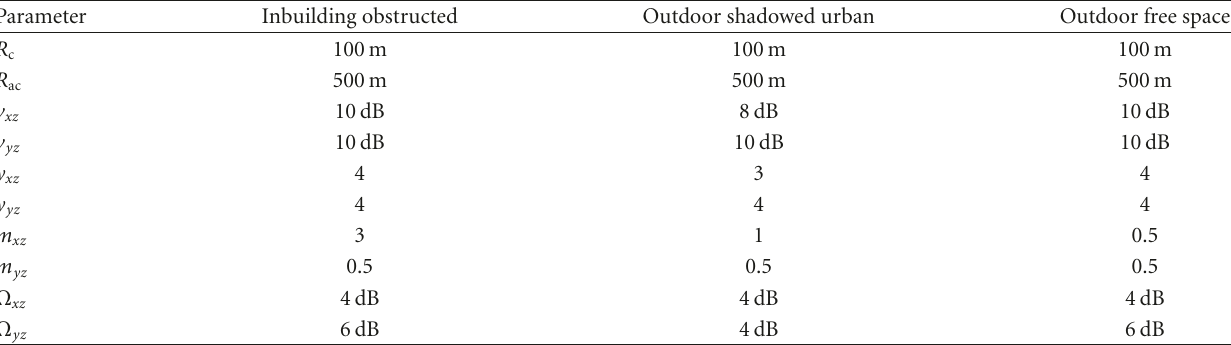
Table 2: System parameters for Figure 3.